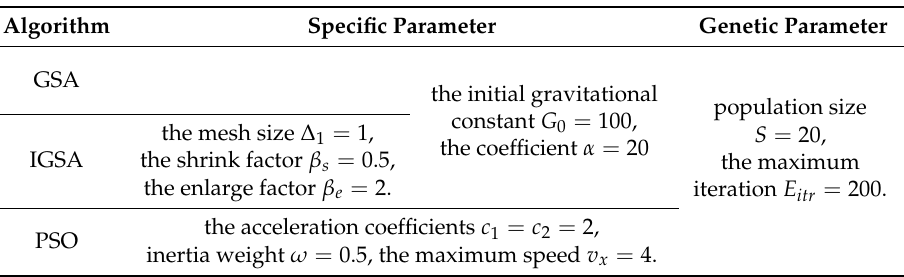
Table 1. Parameter setting for